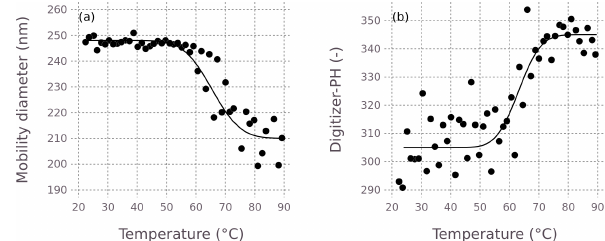
Figure 9. The phase transition of bisphere organic particles be- tween 20 and 90 ◦ C. Black lines correspond to those of a fit- ted logistic curve. (a) Phase transition of dimers for the nomi- nal 166nm glucose–sucrose particles versus temperature. The mid- point of the transition is Tr ± σ = 65 . 5 ± 9 . 8 ◦ C. (b) Temperature scans of digitizer-PH for the nominal 166nm glucose–sucrose par- ticles versus temperature. The midpoint of the relaxation is Tr ± σ = 63 . 1 ± 5 . 9 ◦